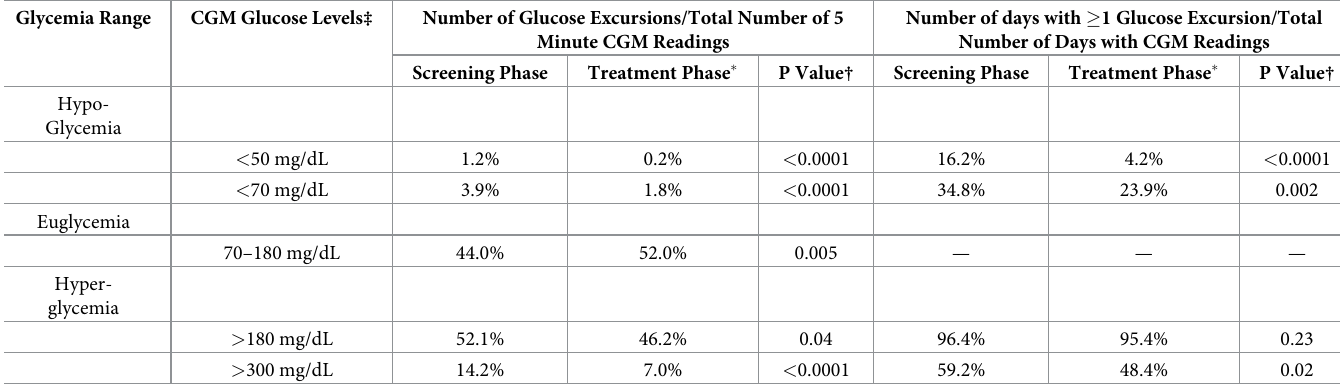
Table 4. Frequencies of CGM glycemic excursions.